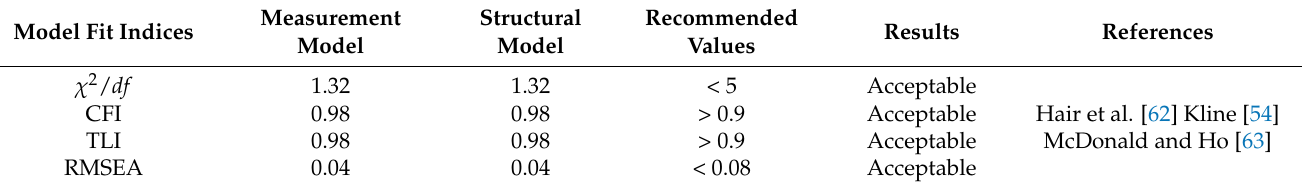
Table 3. Results of the measurement model and structural model assessments.